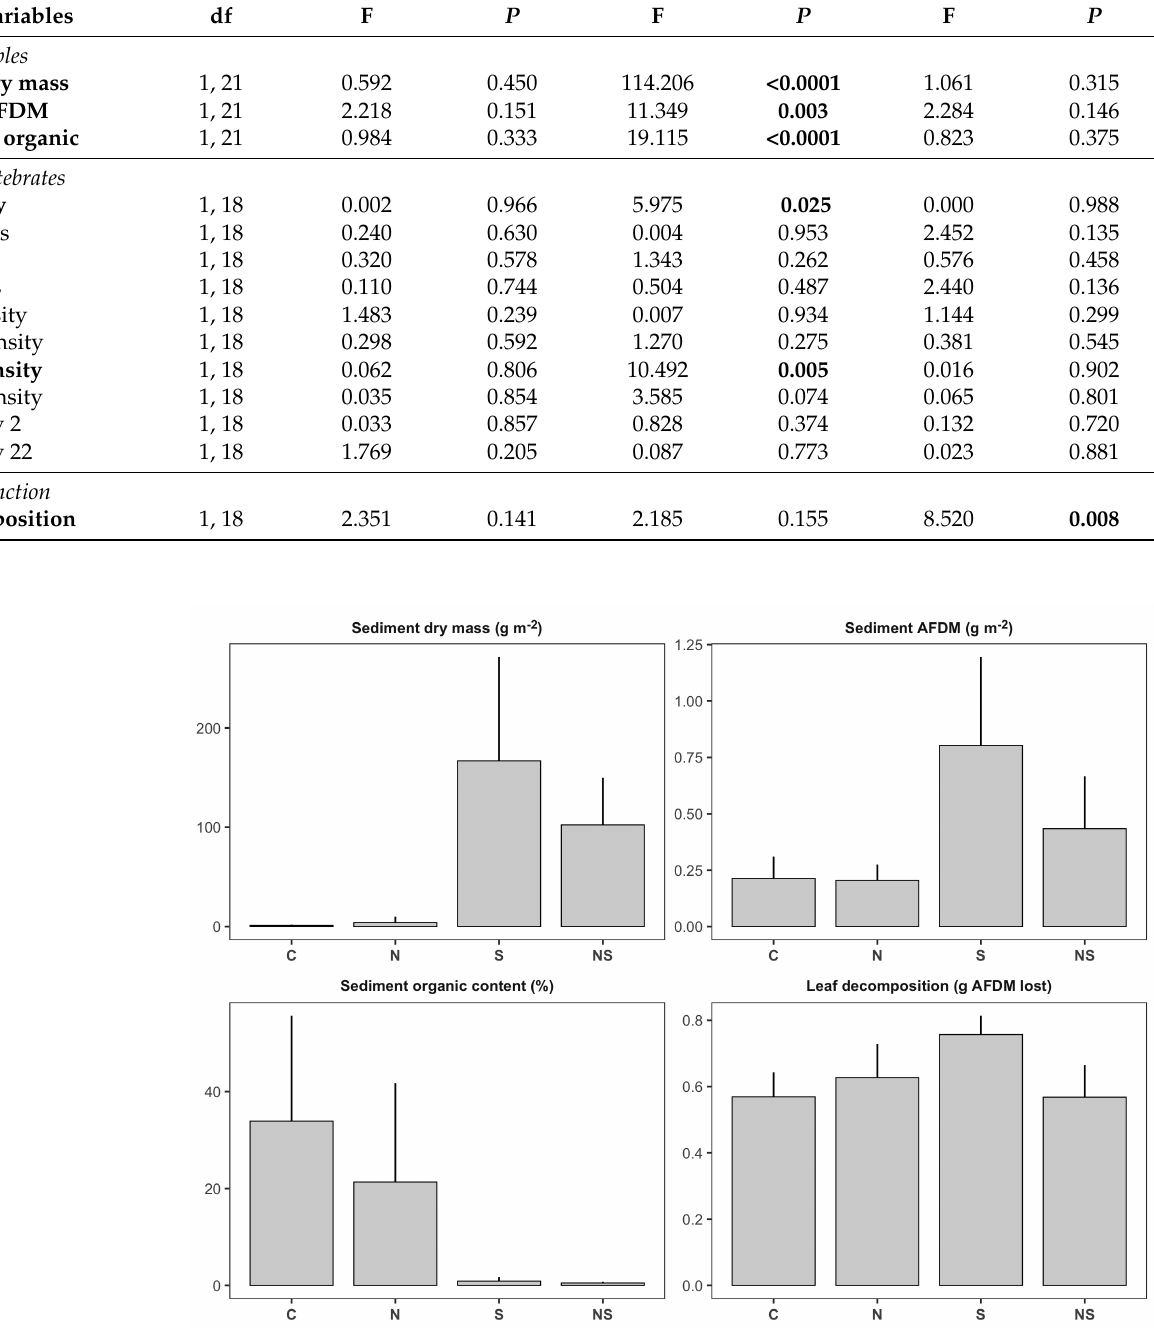
SD) of habitat and ecosystem function variables Figure 2. Bar plots illustrating treatment means ( ± in first-order channels: control ( n = 9), sediment (S, n = 3), nutrients (N, n = 3), nutrients + sediment (NS, n = 9). Y-axis units for each panel are indicated in the panel’s